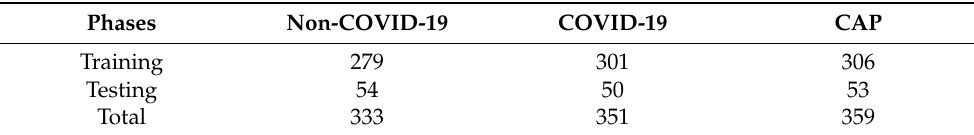
Figure 2. A sample of the experimental chest X-ray dataset: ( a ) normal or healthy chest, ( b ) COVID-19, and ( c ) pneumonia. Table 2. Per class CT scan images applied in the training and testing phases.